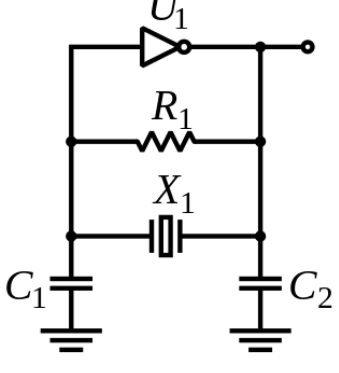
Figure 16. Pierce